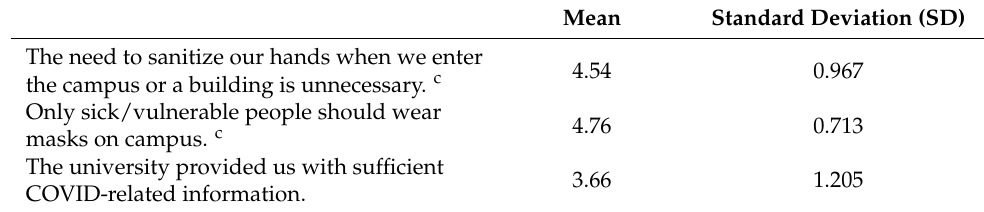
Table 6. Students’ attitudes towards the protective measures implemented.